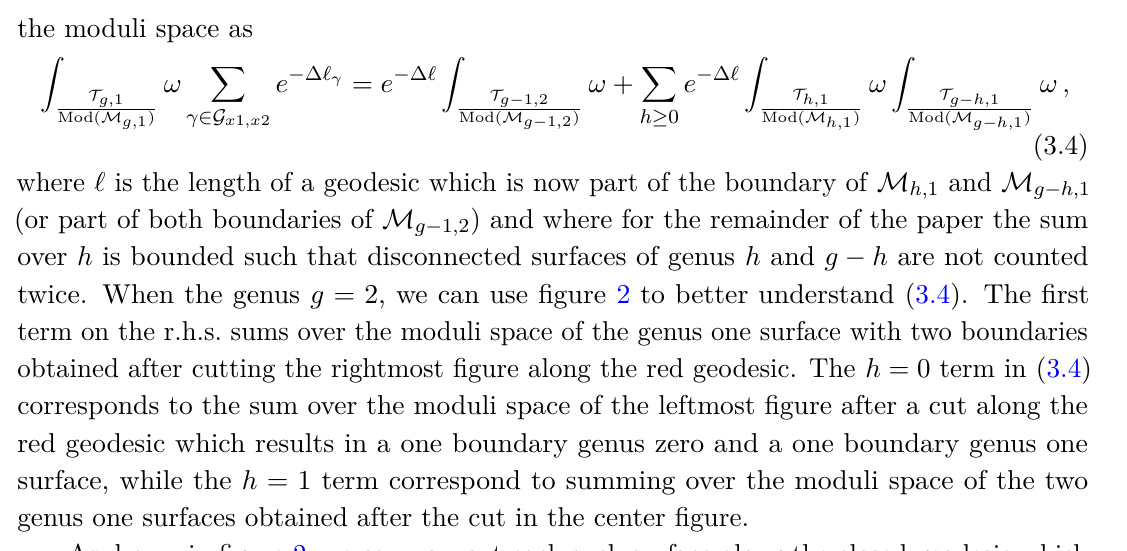
Figure 2 . An example (with genus 2) of the type of hyperbolic surfaces which the path integral (3.3) sums over. The green curves represent the wiggly asymptotic boundaries, while the red curve represents the boundary to boundary geodesic. While there are an infinite number of non-self- intersecting boundary-to-boundary geodesics on such surfaces, above, we have drawn an example of all possible surface topologies that can result by cutting a genus two surface along the geodesics. The purple curves represent the closed geodesics which we use to glue the trumpet wavefunctions in (3.7) to different bordered Riemann